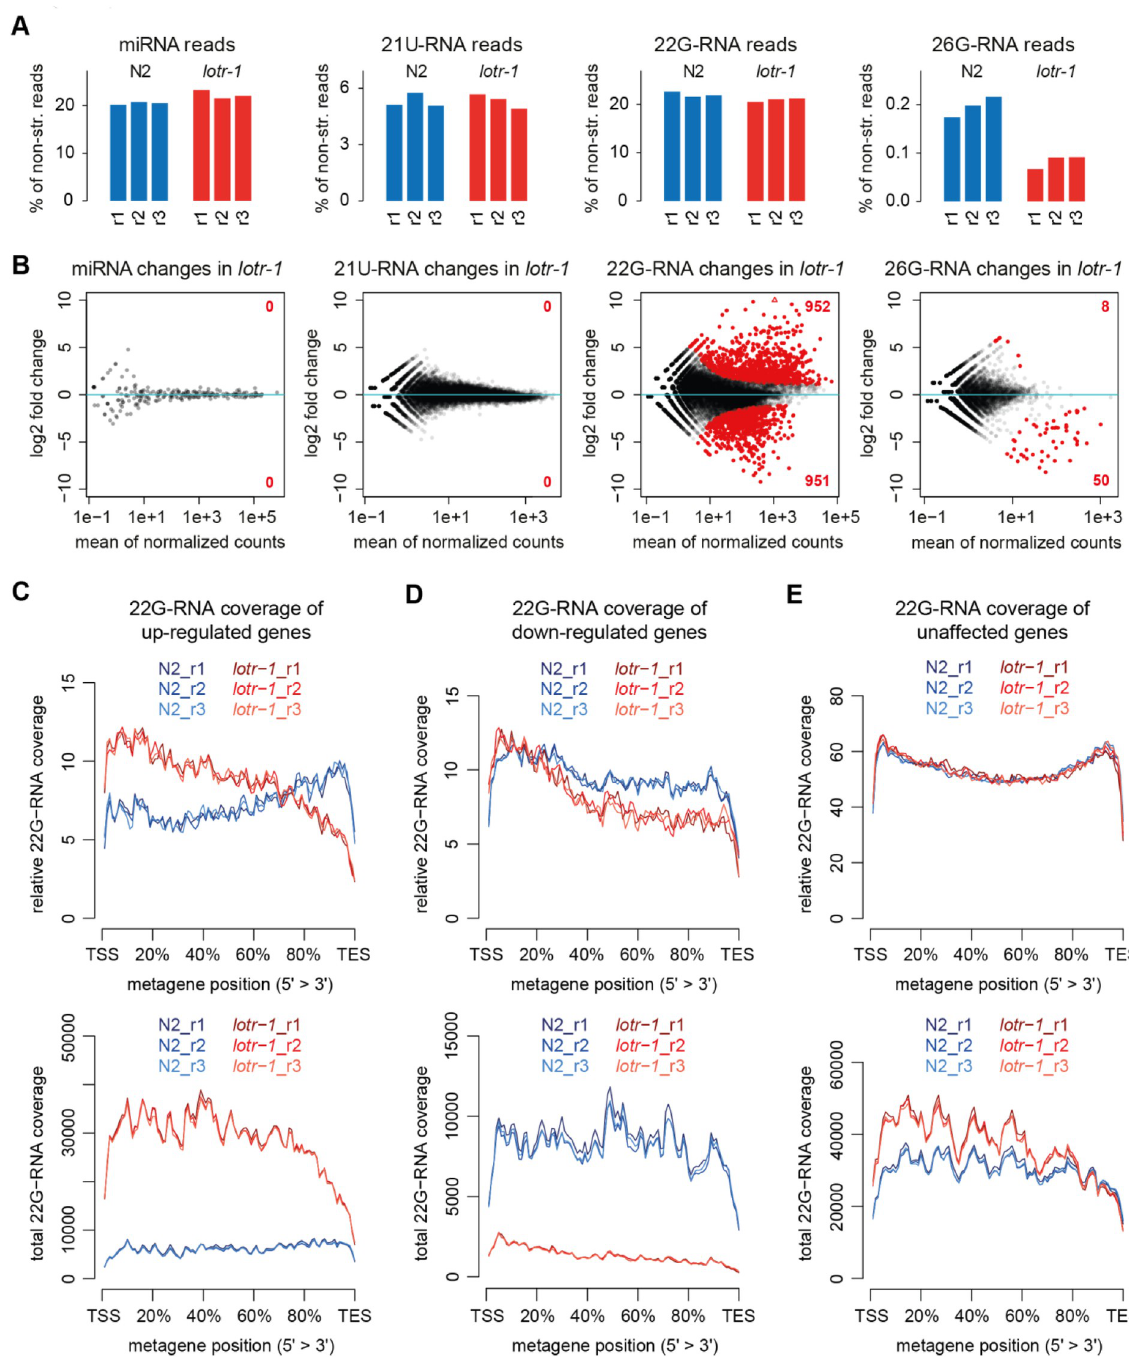
Fig 4. 26G- and 22G-RNA deregulation in lotr-1 mutants. A) Relative levels of the indicated small RNA populations normalized to all non- structural reads. B) Differential expression analysis to determine genes and transposons that are significantly depleted or enriched of mapped small RNAs in lotr-1 mutants. The MA plots depict DESeq2 differential results for miRNAs (n = 257), 21U-RNAs over 21ur loci (n = 14328), and 22G-/26G-RNAs over protein coding genes (n = 20222), lincRNAs (n = 172), pseudogenes (n = 1791) and transposons (n = 151); significant changes ( > 2-fold at 10% FDR) are colored in red with the number of up- and down-regulated hits indicated. C-E) Metagene plots depicting relative (normalized per individual gene as in [71], upper panels) as well as total (lower panels) 22G-RNA coverage over genes whose 22G-RNAs are up-regulated, down-regulated or unaffected in the lotr-1 mutants. Note that the total (cumulative) coverage plots utilize DESeq2-based normalization for library composition and are biased towards genes with strong 22G-RNA levels. TSS/TES, transcription start/ end